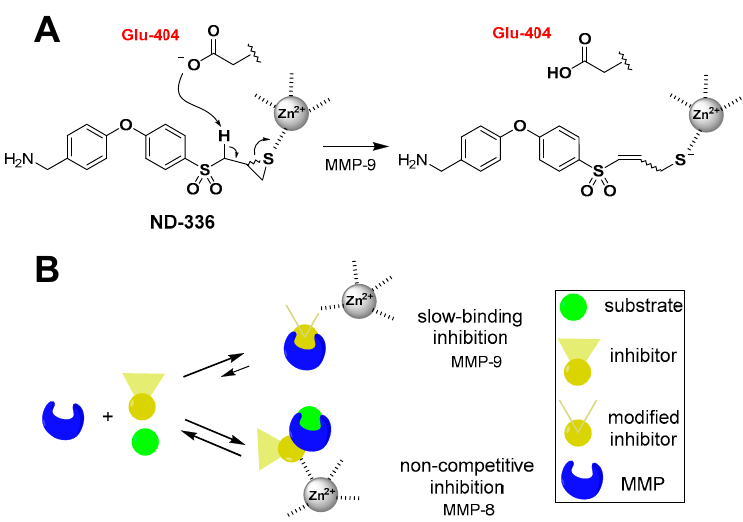
Figure 9. Mechanism of inhibition of ( R )-ND-336. ( A ) ( R )-ND-336 inhibits MMP-9 as a mechanism-based inhibitor, where Glu-404 at the active site abstracts a proton α to sulfone, resulting in the corresponding thiolate that coordinates with zinc ion as a tight-binding inhibitor, for which the reversal occurs very slowly. ( B ) ( R )-ND-336 inhibits MMP-9 as a slow-binding inhibitor with a long residence time of 300 ± 1 min. The compound is a poor non-competitive inhibitor for MMP-8, for which the residence time is very short. Adapted from Nguyen et al. [48].